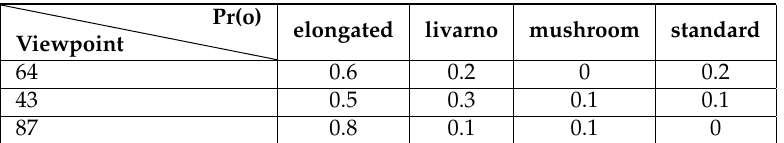
Table 2. Observation probability distribution for the single-position case when the underlying object is of the elongated class. Pr(o) elongated livarno Viewpoint